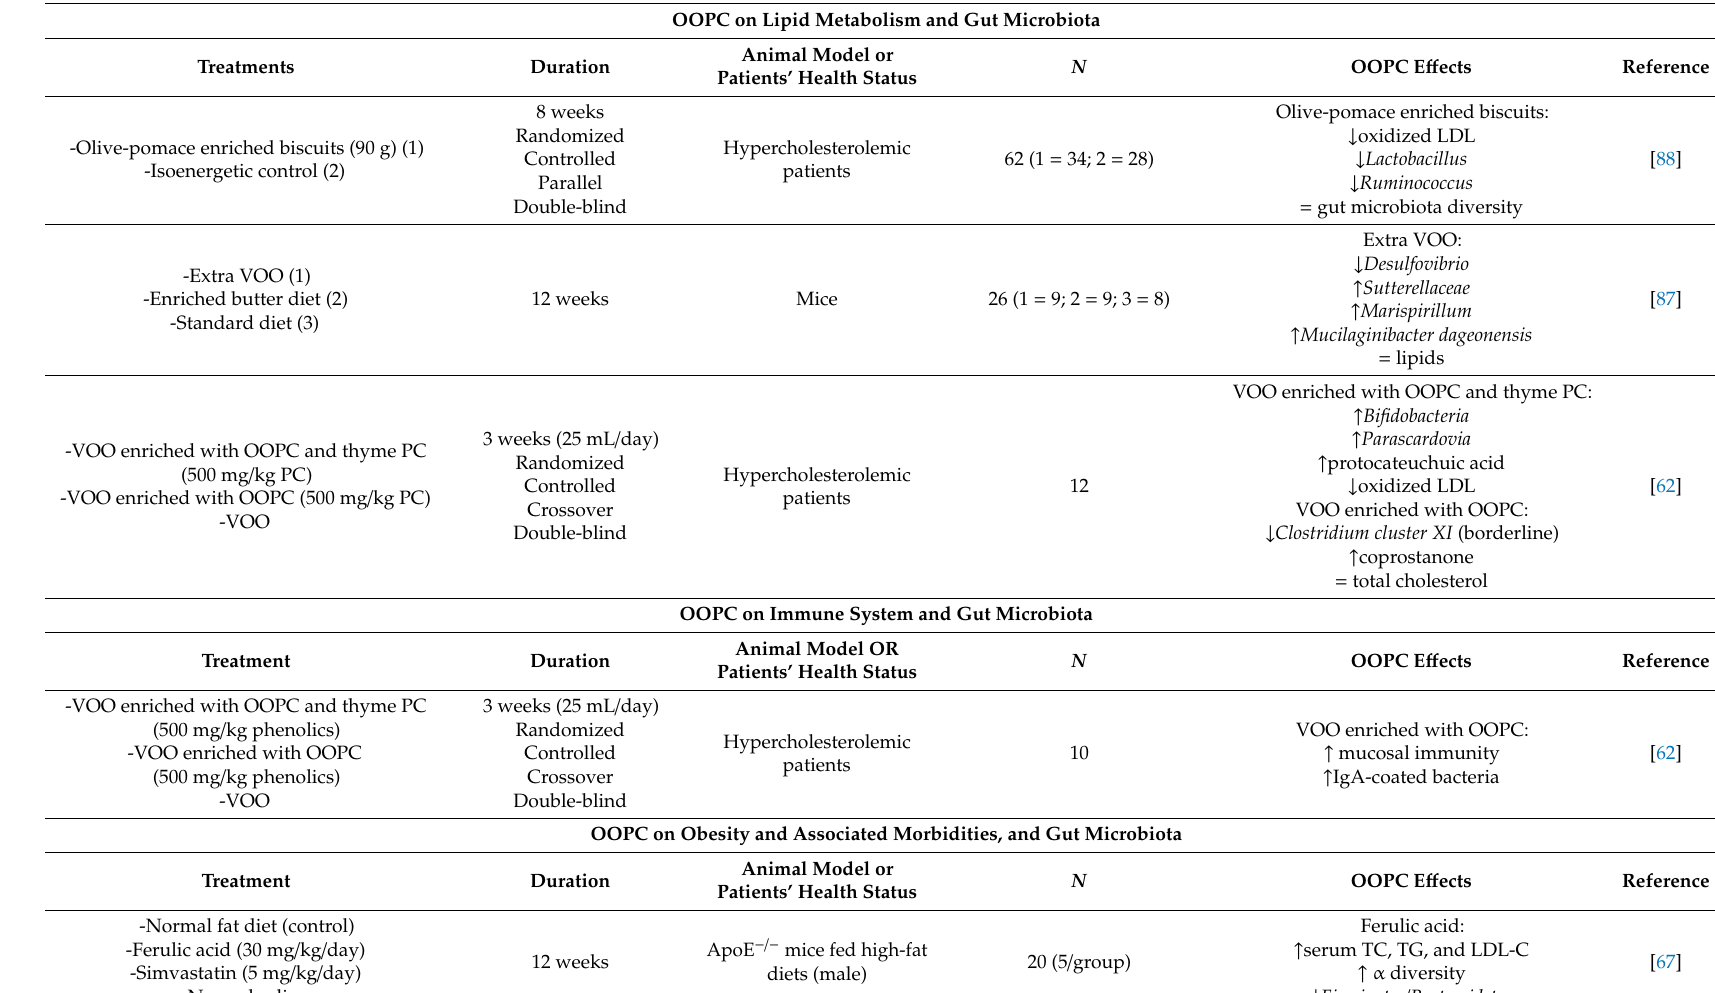
Table 2. In vivo studies assessing the e ff ects of OOPC on gut microbiota, lipid metabolism, immune system, and obesity and associated